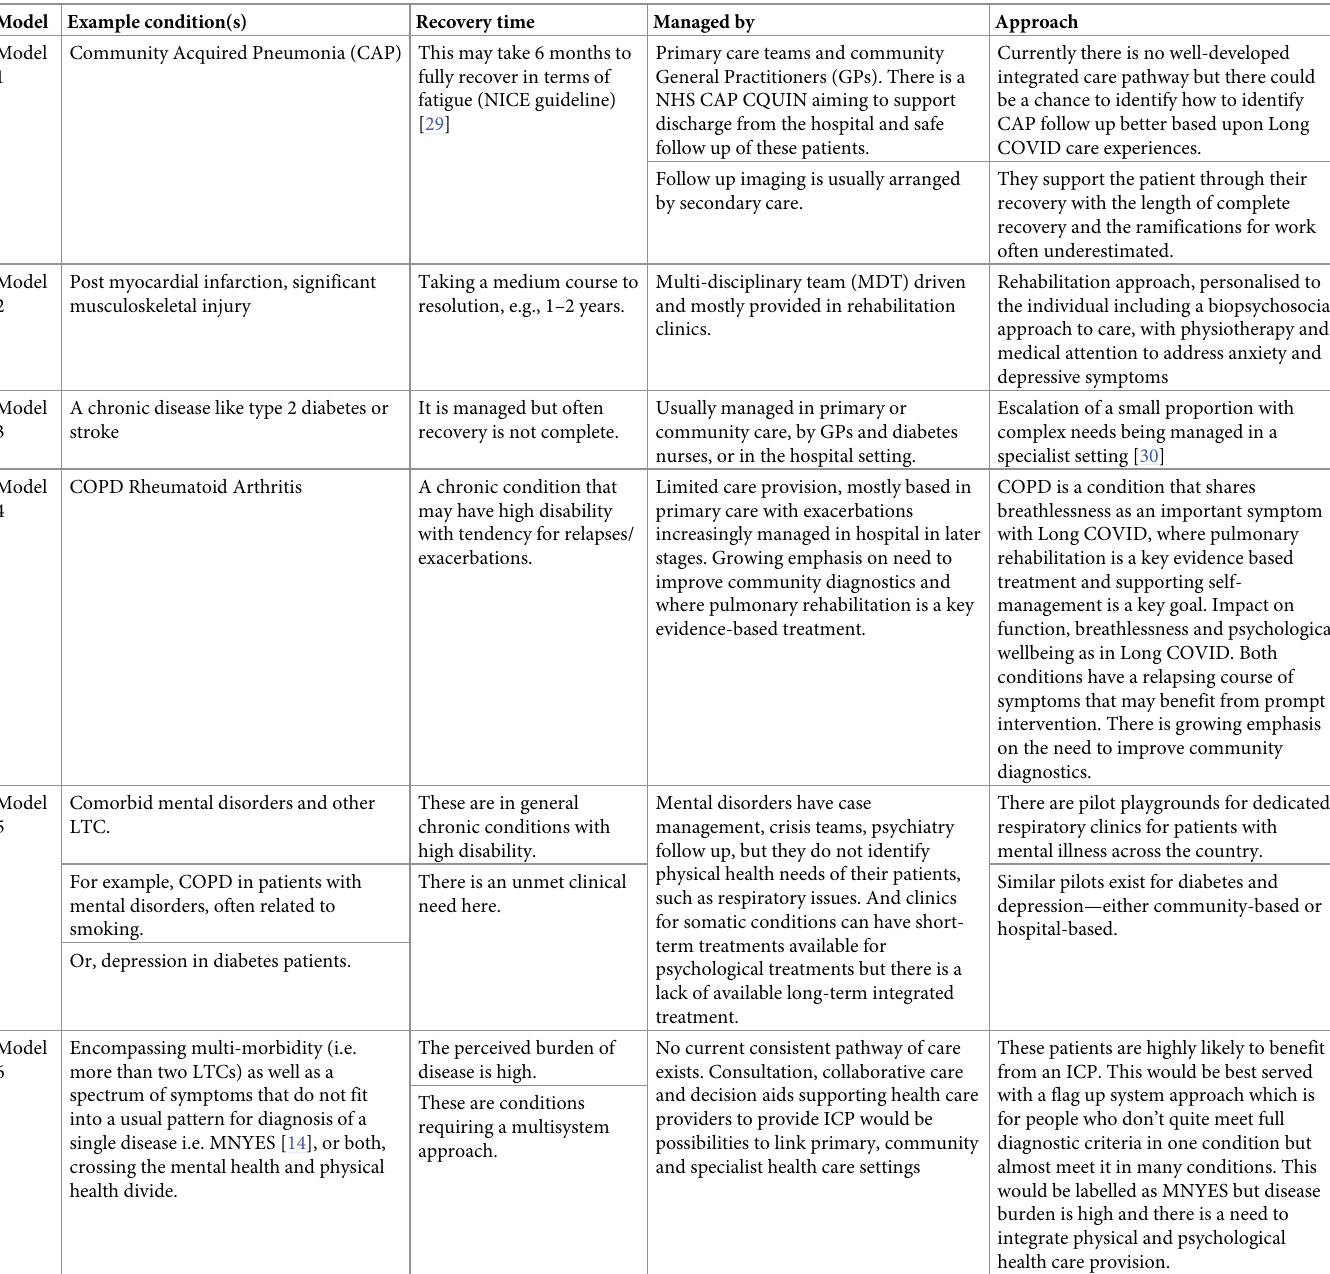
Table 1. Potential models for ICPs managing recovery in Long COVID and other